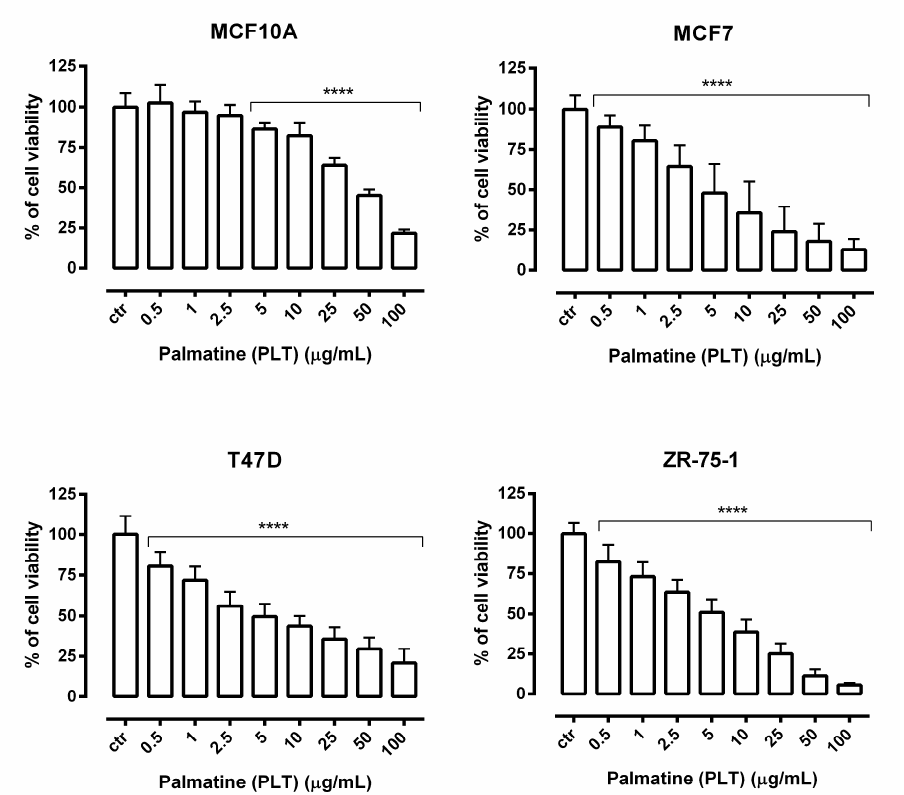
Figure 3. The effect of palmatine (PLT) on the viability of human breast cancer cell lines was measured by MTT assay after 72 h. Results are presented as mean ± SEM at each concentration. (**** p < 0.0001), n = 40 per concentration from five independent